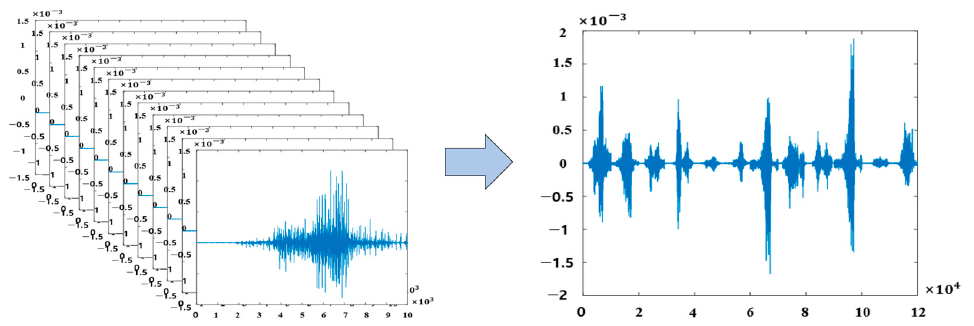
Figure 7. 12-channel synthesis using temporal domain.